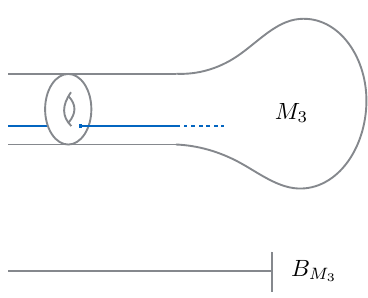
2 boundary and a codimension-2 defect intersecting the Figure 1 . A three-manifold M 3 with T boundary T 2 at a point corresponds to a boundary condition B M in the 4d = 2 (cid:3) theory. 3 N theory denoted by ( M 3 ) with a distinguished u (1) f (cid:13)avour symmetry corresponding T